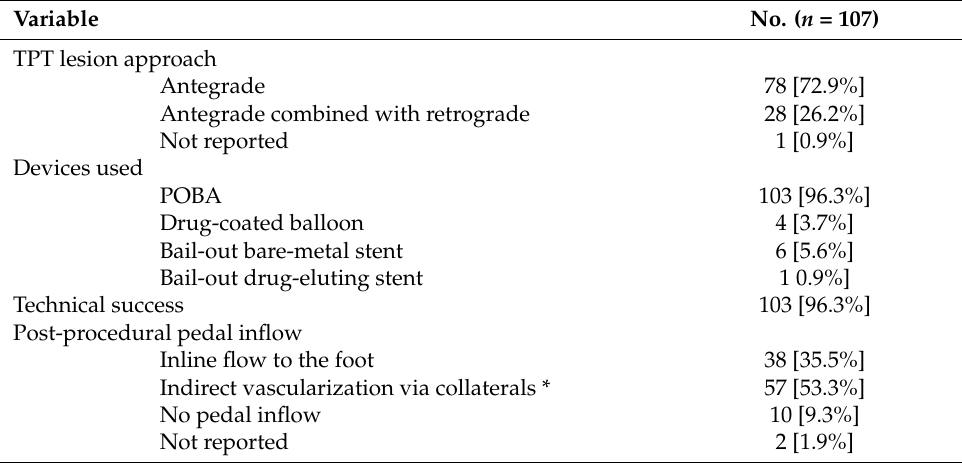
Table 3. Procedural characteristics.